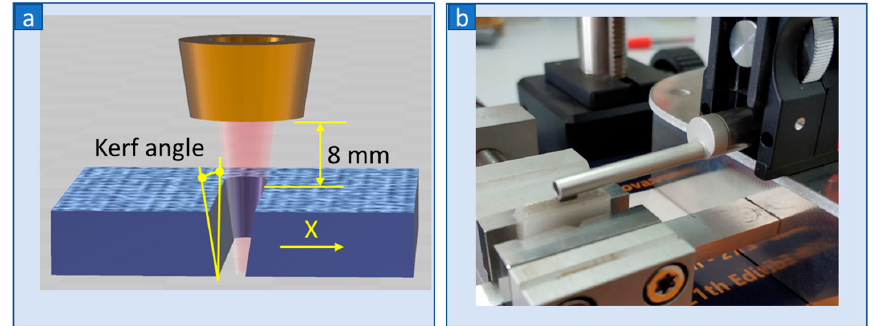
Figure 3. ( a ) Kerf angle, ( b ) specimen, and Ra measurements.